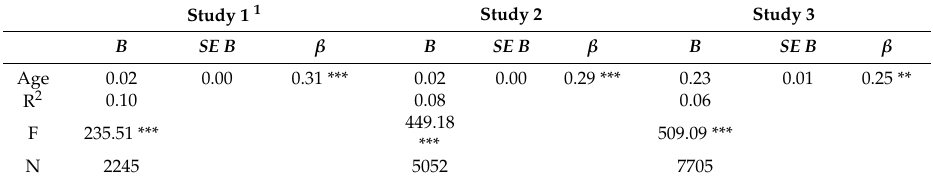
Table 7. Results of Linear Regression Analyses of Age Predicting